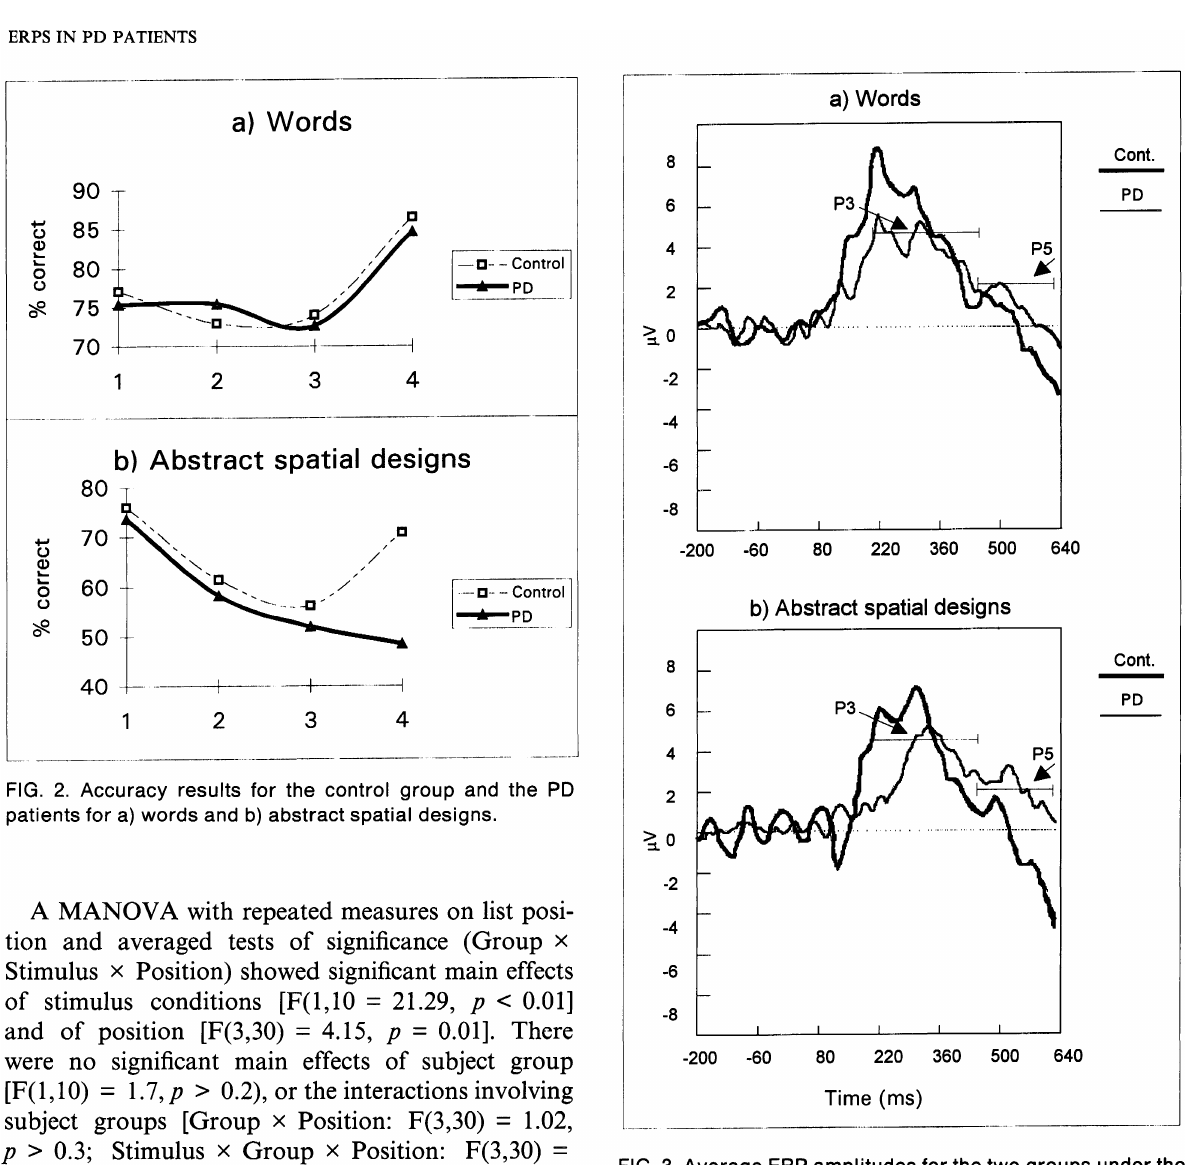
FIG. 3. Average ERP amplitudes for the two groups under the two conditions recorded after presentation of the probe